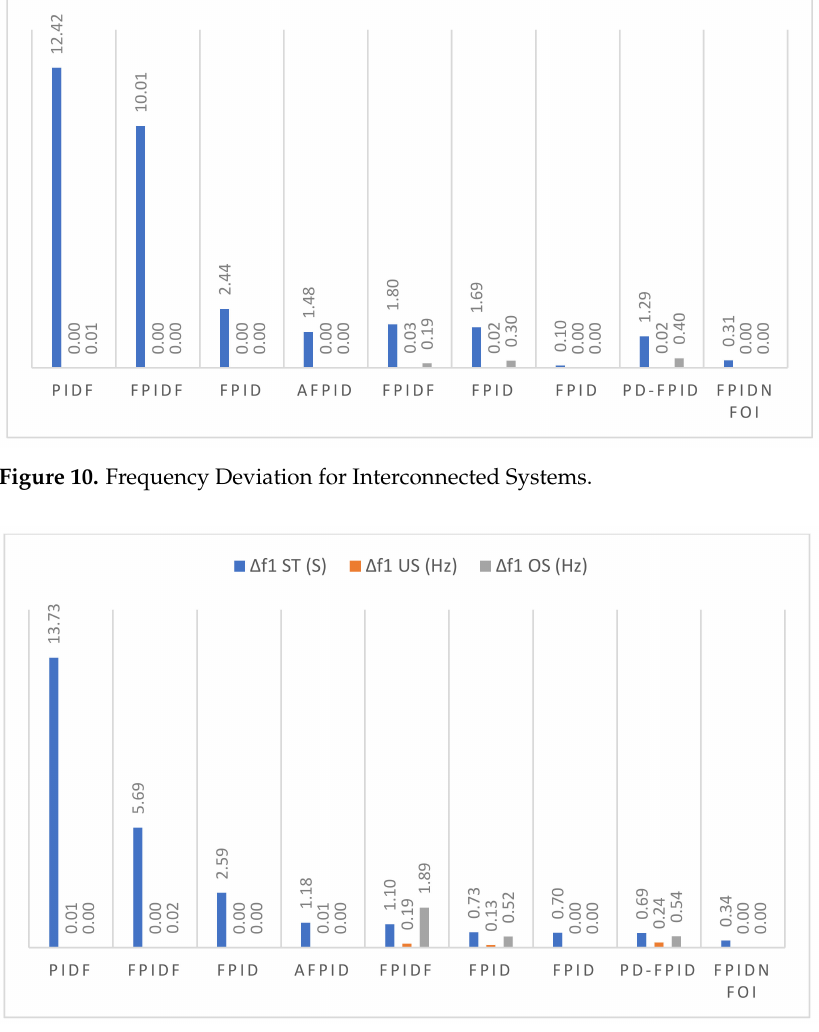
Figure 11. Frequency Deviation for Interconnected